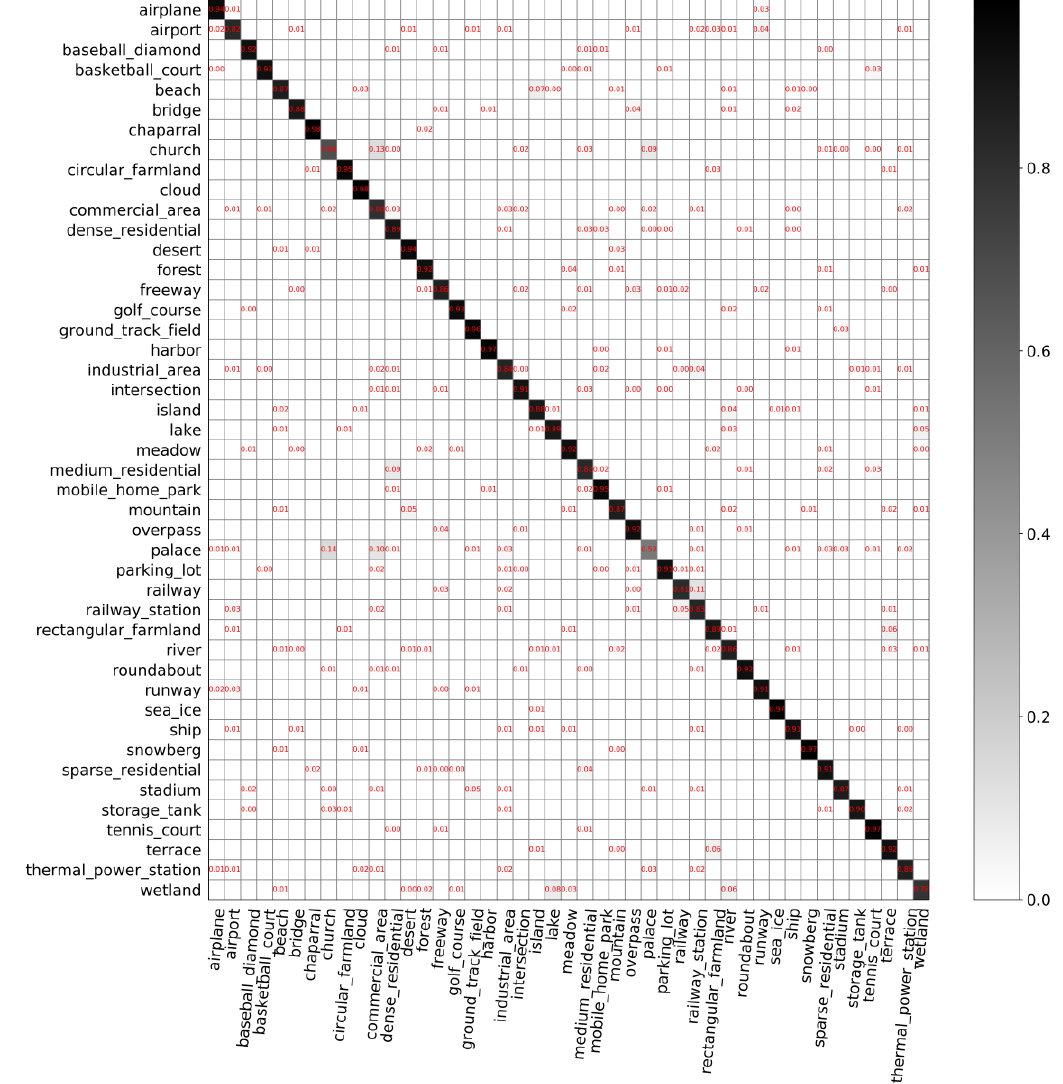
Figure 7. Confusion matrix on NWPU-RESISC45 with training set of 5% and validation set of 5%.